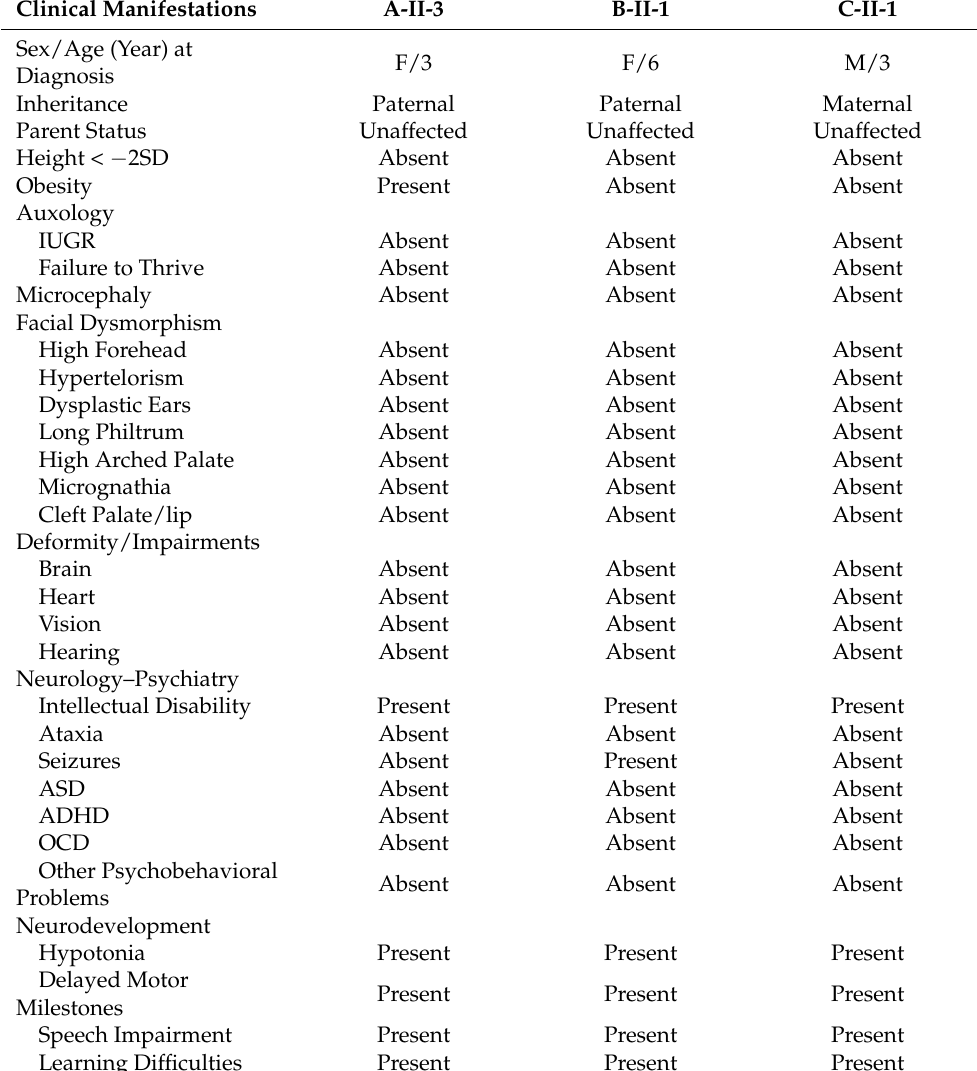
Table 1. Comparison of the clinical manifestations between three cases with 15q11.2 breakpoint (BP) 1 and BP2